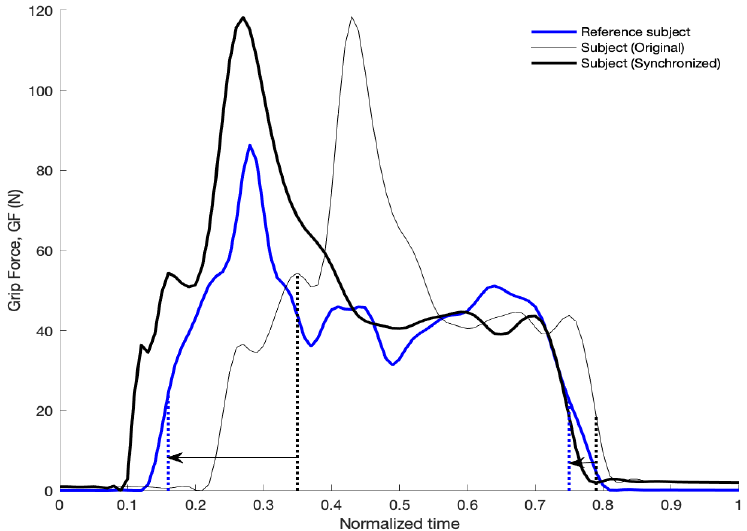
Figure 4. Time warping of the grip force (GF) curve corresponding to subject 1 for task 2, including the reference subject curve and Table 1. t1ref = 0.16, t2ref = 0.75, t1 = 0.35, t2 = 0.79.